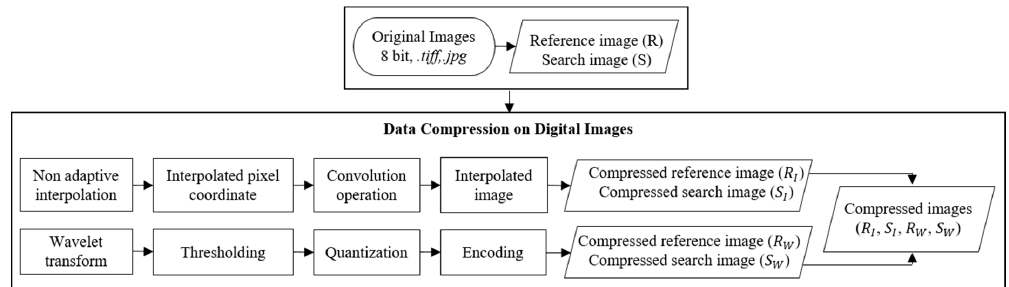
Figure 3. Proposed framework for digital image data compression.